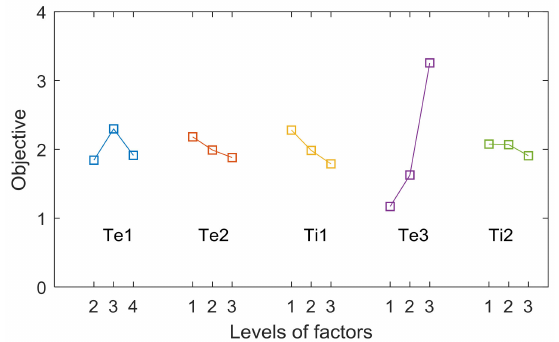
Figure 6. Average objectives for all factors.